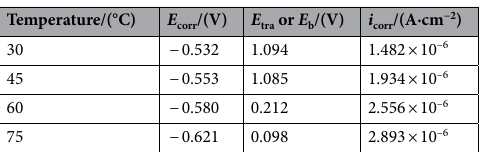
Table 4. Fitting results of polarization curve of 2205 DSS at different